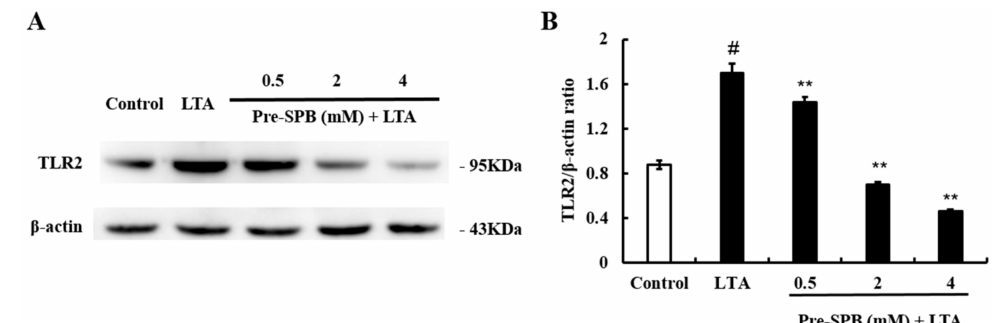
Figure 3. The effect of SPB on TLR2 expression. The expression of TLR2 was investigated in MAC-T cells using Western blot analysis. β -actin was used as a reference control. ( A ) The expression levels of toll-like receptor 2 (TLR2); and ( B ) The quantification histogram of TLR2 protein expression normalized by β -actin. The values presented are the mean ± SE of three independent experiments. # p < 0.05 vs. control group; ** p < 0.01 vs. LTA